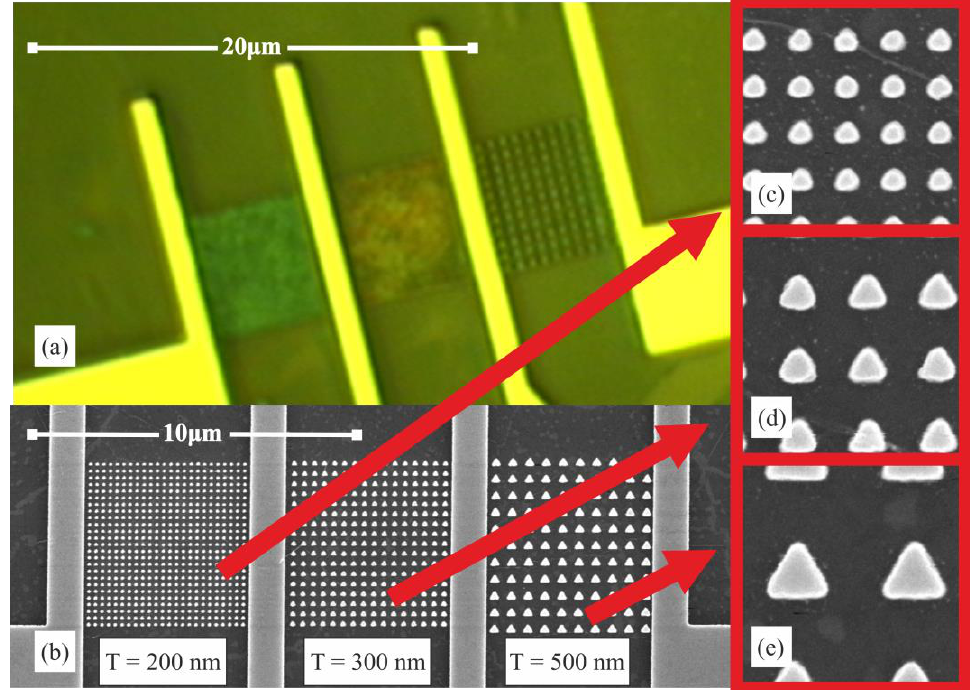
Figure 2. Image of the created photodetectors: ( a ) optical image, ( b ) SEM image of the overall structure, ( c – e ) SEM images of nanoprisms with periods T = 200, 300, and 500 nm, respectively.